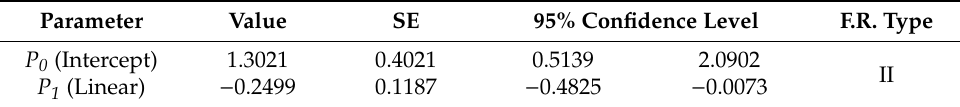
Table 2. Parameters and statistical significance for the functional response equations type I, II, and III when different densities of Phthorimaeae operculella eggs were exposed to the adult female of Blattisocius tarsalis , for 24 hours, under laboratory conditions.